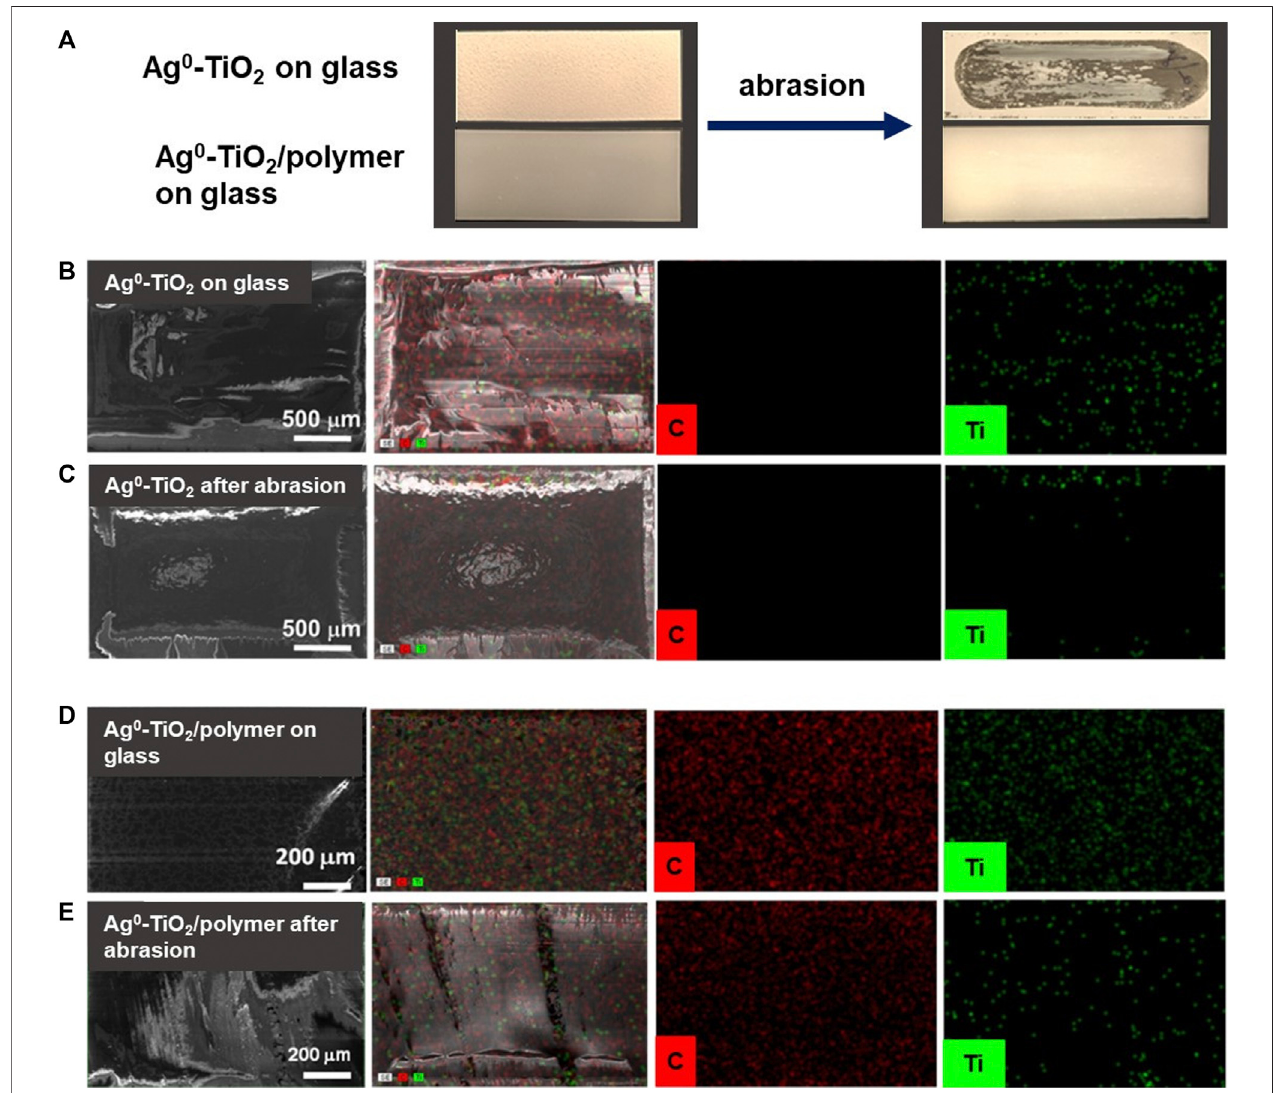
FIGURE 9 | The photos (A) and the corresponding SEM and EDX images for carbon (red) and titania (green) content of the pure Ag 0 -TiO 2 (B, C) and polyacrylate based composite (60 wt% Ag 0 -TiO 2 /40% polymer) (D, E) fi lms before and after the abrasion test.